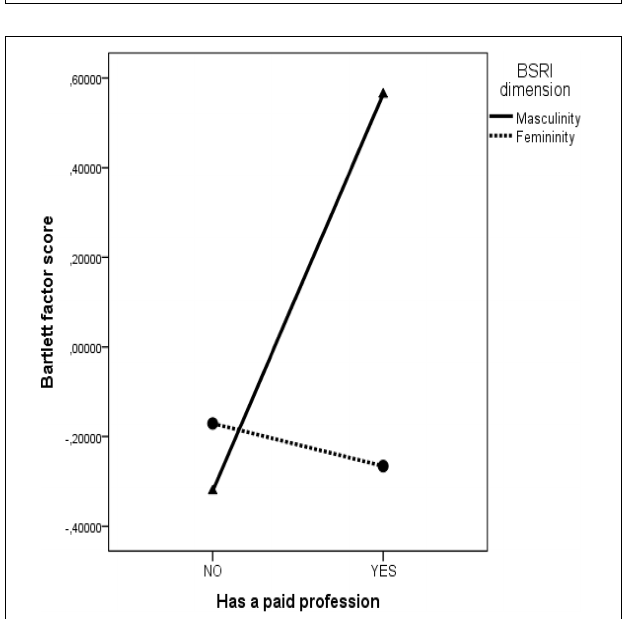
FIGURE 3 | Masculinity and femininity as a function of paid